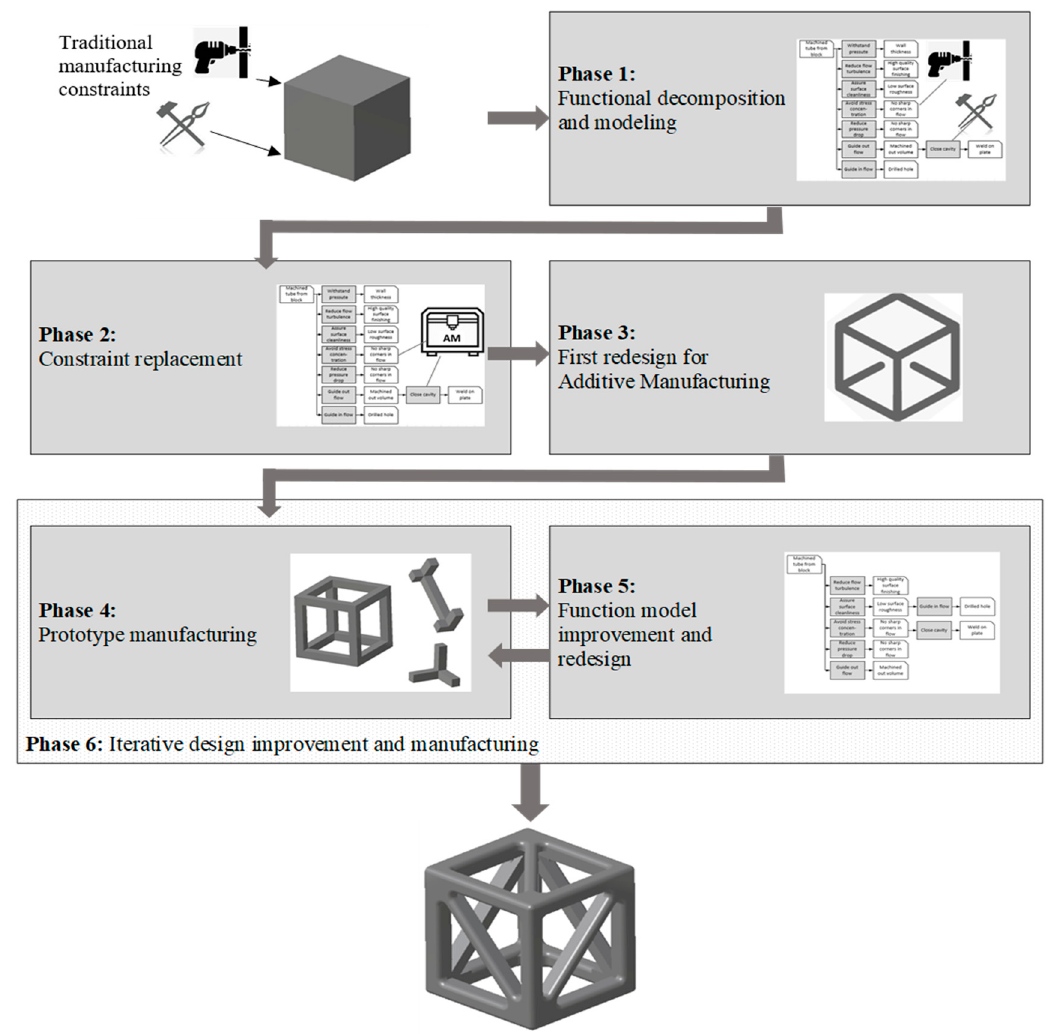
Figure 1. Proposed function model-based design for Additive Manufacturing (DfAM) method. The diagram highlights the iterative process of the prototyping activities.